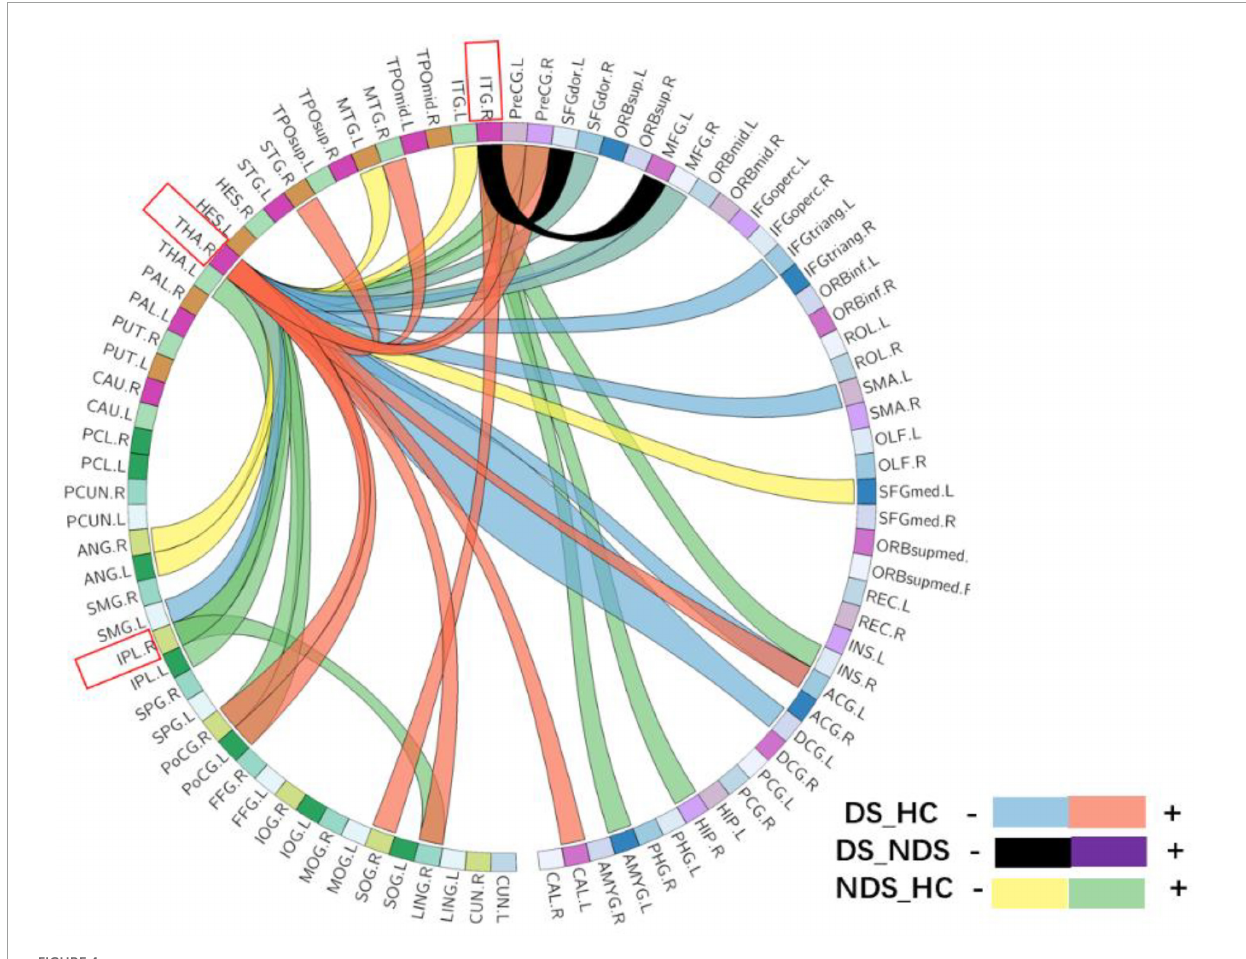
FIGURE4 The circular graph obtained by comparing the functional connections between the three groups based on the three region of interests (ROIs) (IPL.R, THA.R, ITG.R). IPL.R, right inferior parietal lobule; THA.R, right thalamus; ITG.R, right inferior temporal